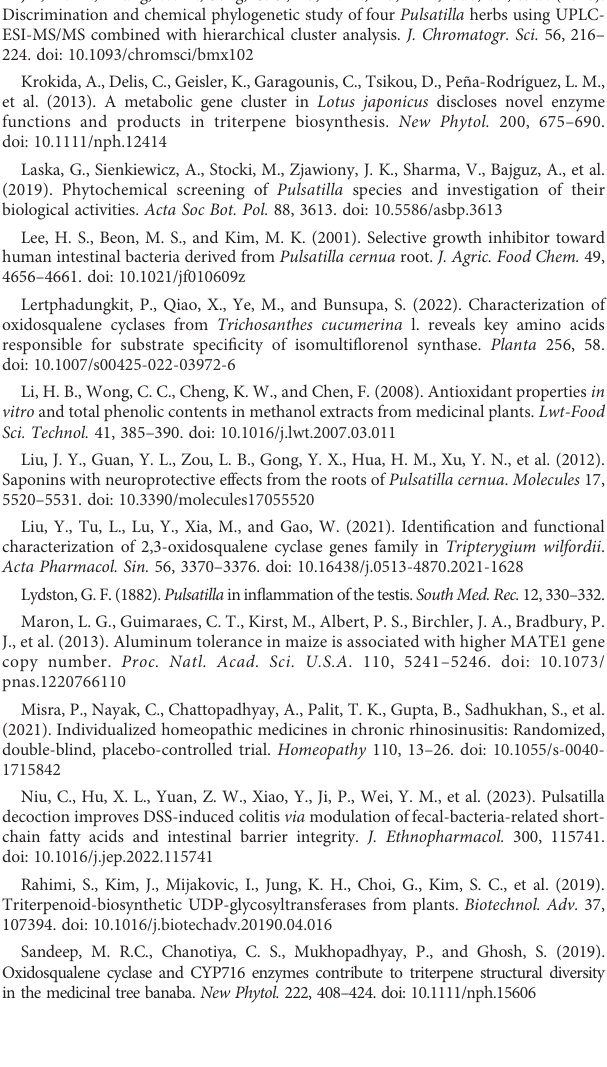
Q397P and both these two sites mutant proteins expressed yeast extraction. The 218 and 189 ion counts of b -amyrin and lupeol are shown, respectively. SUPPLEMENTARY FIGURE 6 Standard curve of 781 -TT ( PchAS ) and 781 -GG ( PcAS ) gene type. SUPPLEMENTARY FIGURE 7 Sequence alignment of AS gene DNA full-length sequences and CDS full-length sequences. SUPPLEMENTARY FIGURE 8 The AS gene core fragment sequences of AS genes cloned from the DNA of Pulsatilla ceruna, P. chinensis and P. turczaninovii . SUPPLEMENTARY TABLE 1 Primers used in this